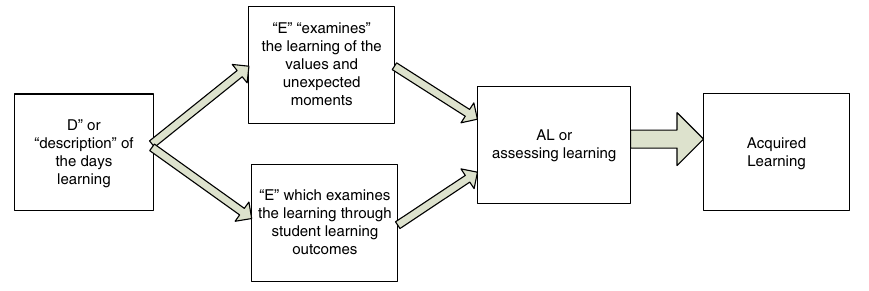
Figure 1. Modified version